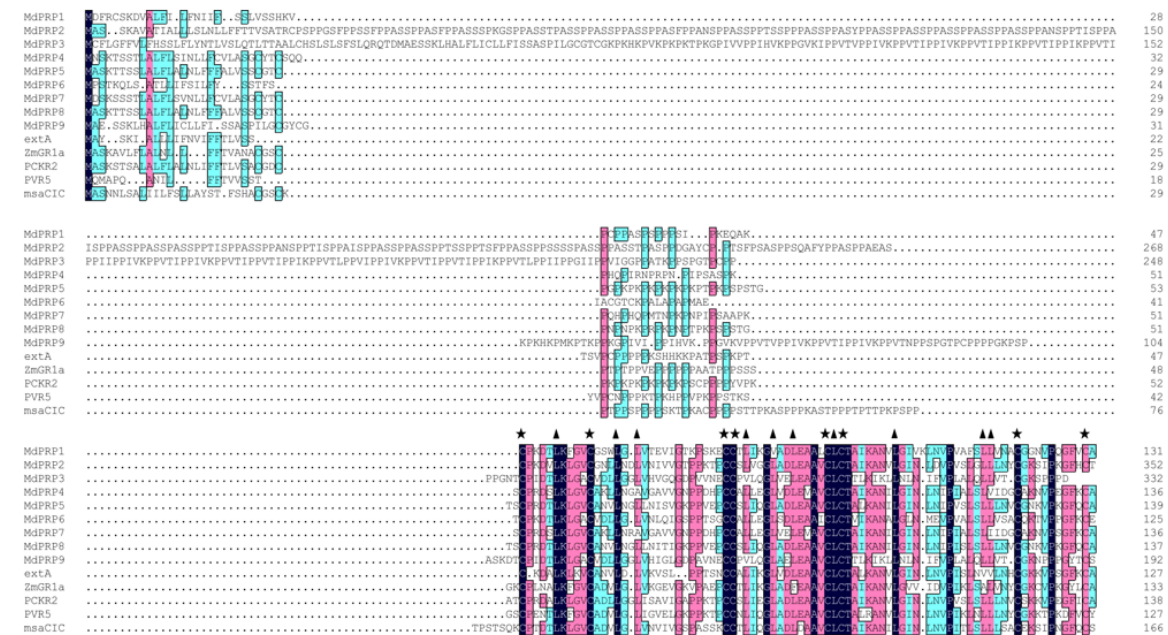
Figure 2. Comparison of deduced amino-acid sequence of MdPRP genes with that of other PRP proteins by DNAMAN software and numbered on the right. msaCIC (L22305), PCKR2 (X85206), extA (X67421), PVR5 (U34333), and ZmGR1a (AB018587) were from Medicago sativa , Asparagus officinalis , Arabidopsis thaliana , Phaseolus vulgaris , and Zea mays , respectively. Asterisks indicate conserved cysteine residue, and triangles indicate conserved Leucine residue in the cysteine-rich domain. Black, purple, and blue indicate that the similarity of each column of amino acids is 100%, 75%, and 50%, respectively.